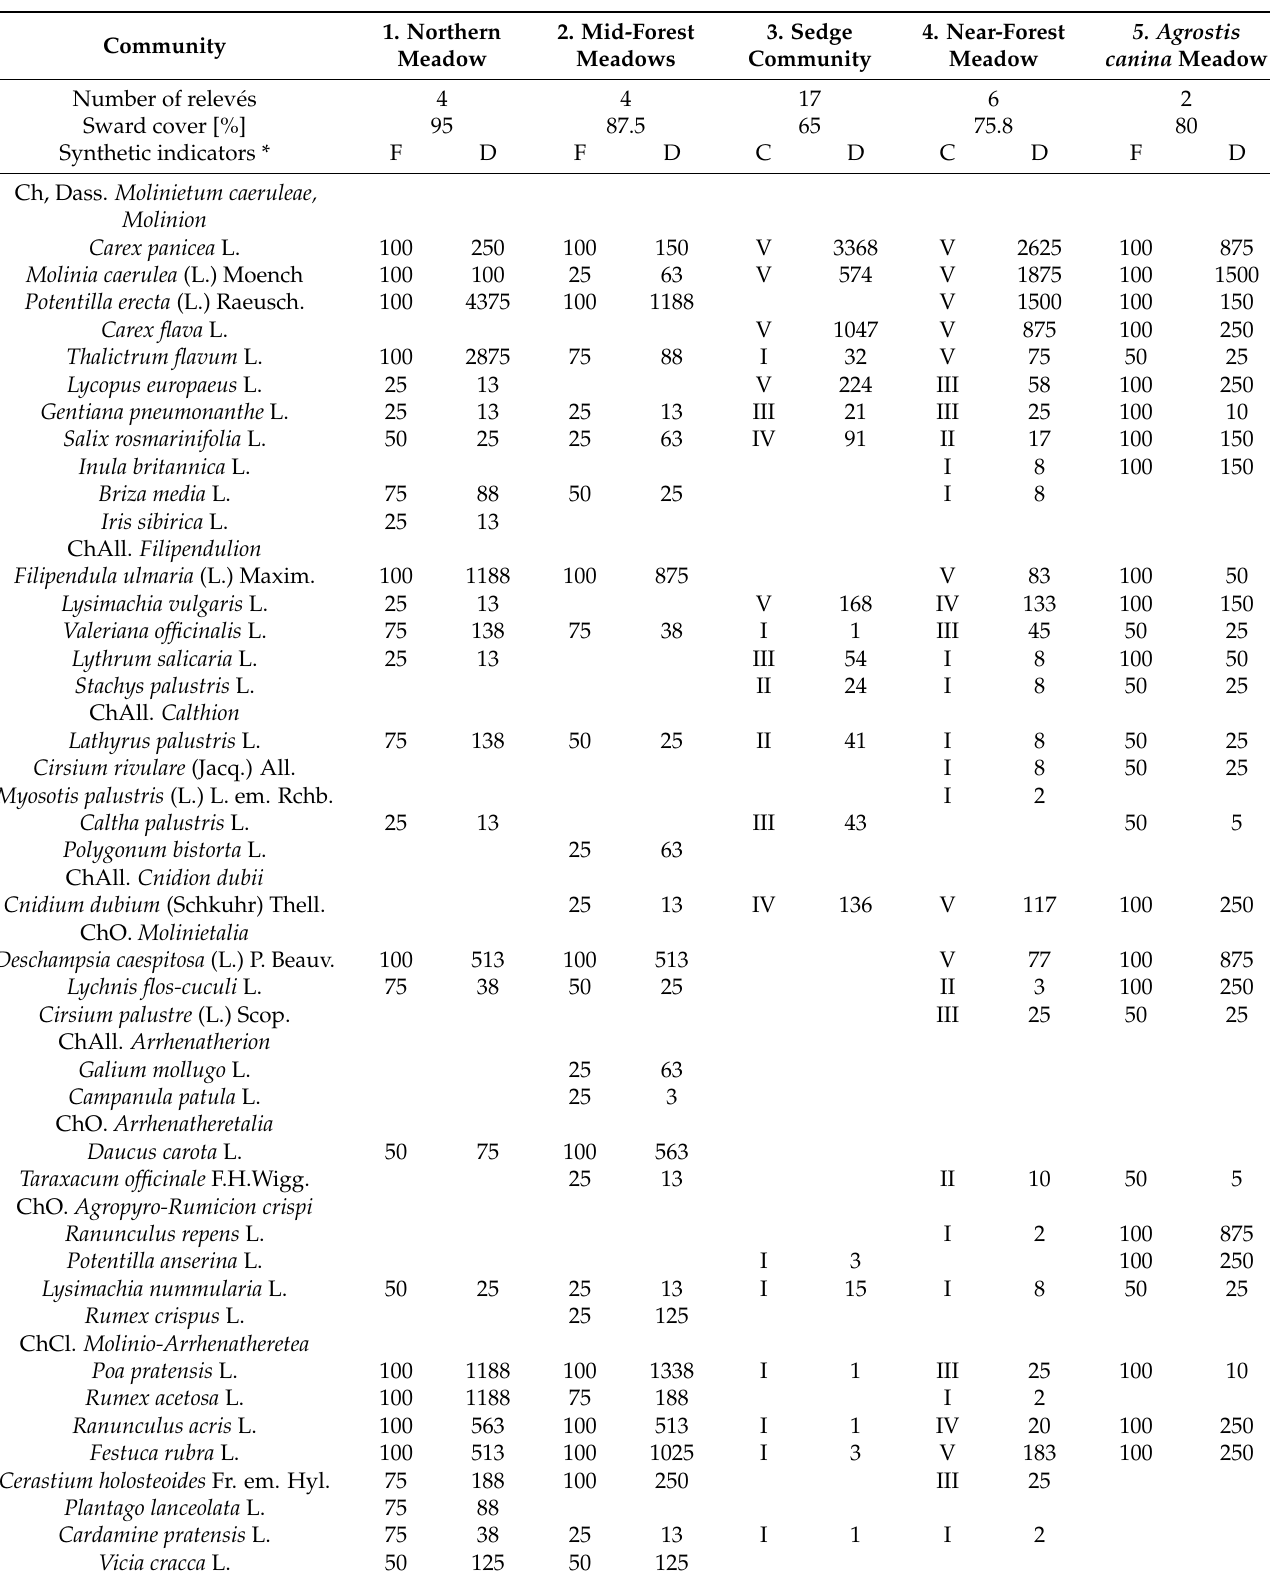
Table A1. Detailed floristic composition (F—frequency, D—mean cover (sum of the mean percentage cover of the species) of plant communities grazed by Konik horses in the Biebrza National